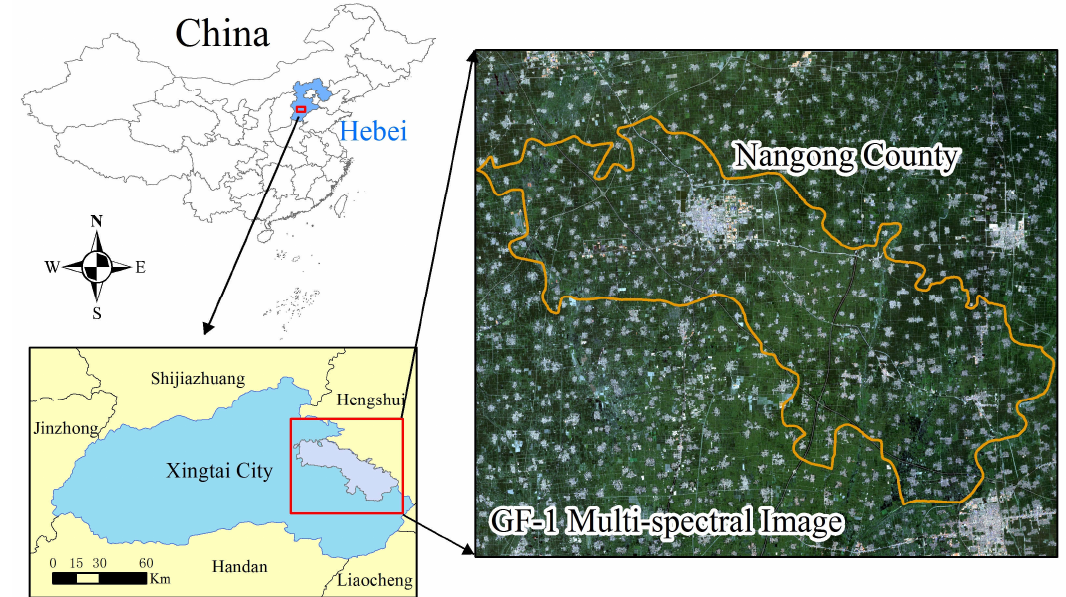
Figure 1. Location map for study area in Xingtai City, Hebei Province, China